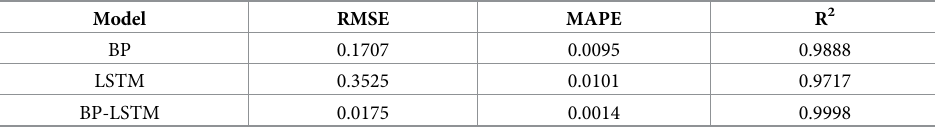
Table 2. Comparison of parameters of different model prediction levels.